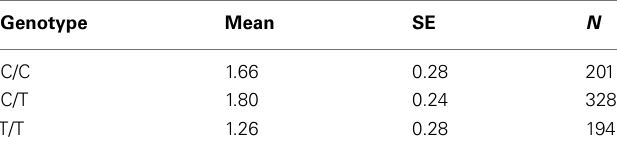
Table 7B |Adjusted mean percent weight gain corresponding to genotypes at rs4712595 ( CDKAL1 ), using model 2.